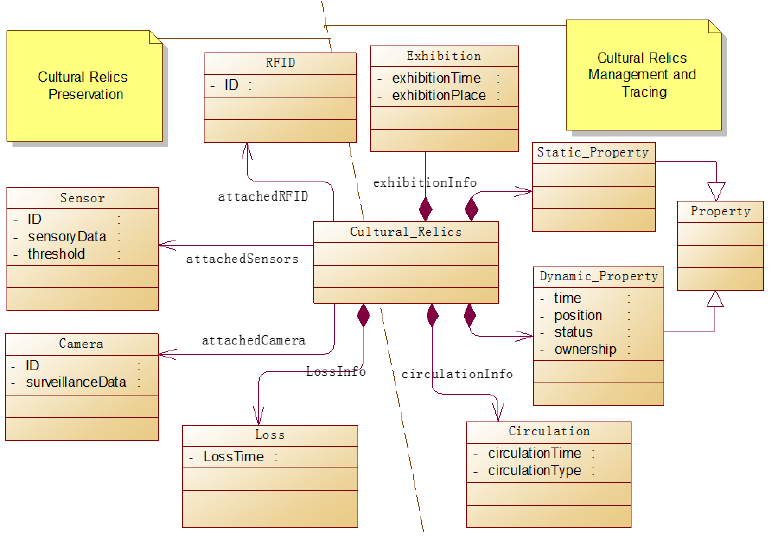
Figure 2. Cultural relics-centric system modeling.